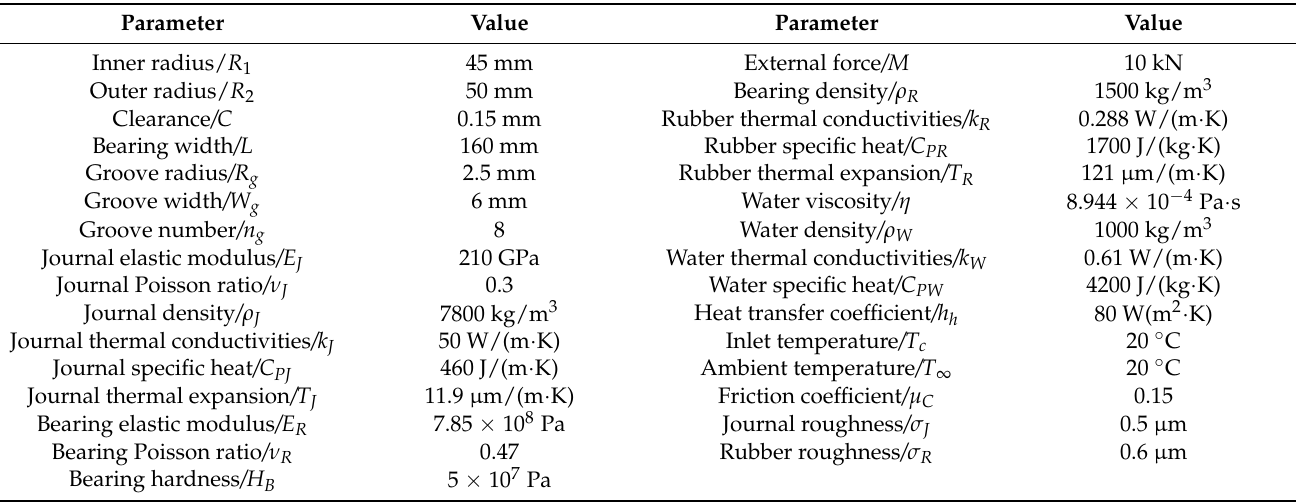
Table 1. The basic parameters of the proposed